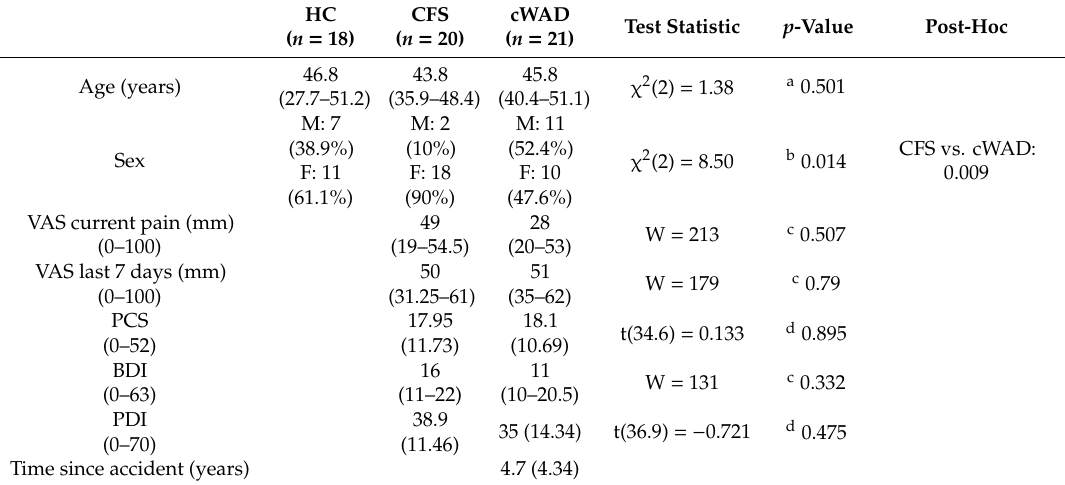
Table 1. Demographics of all participants separated by